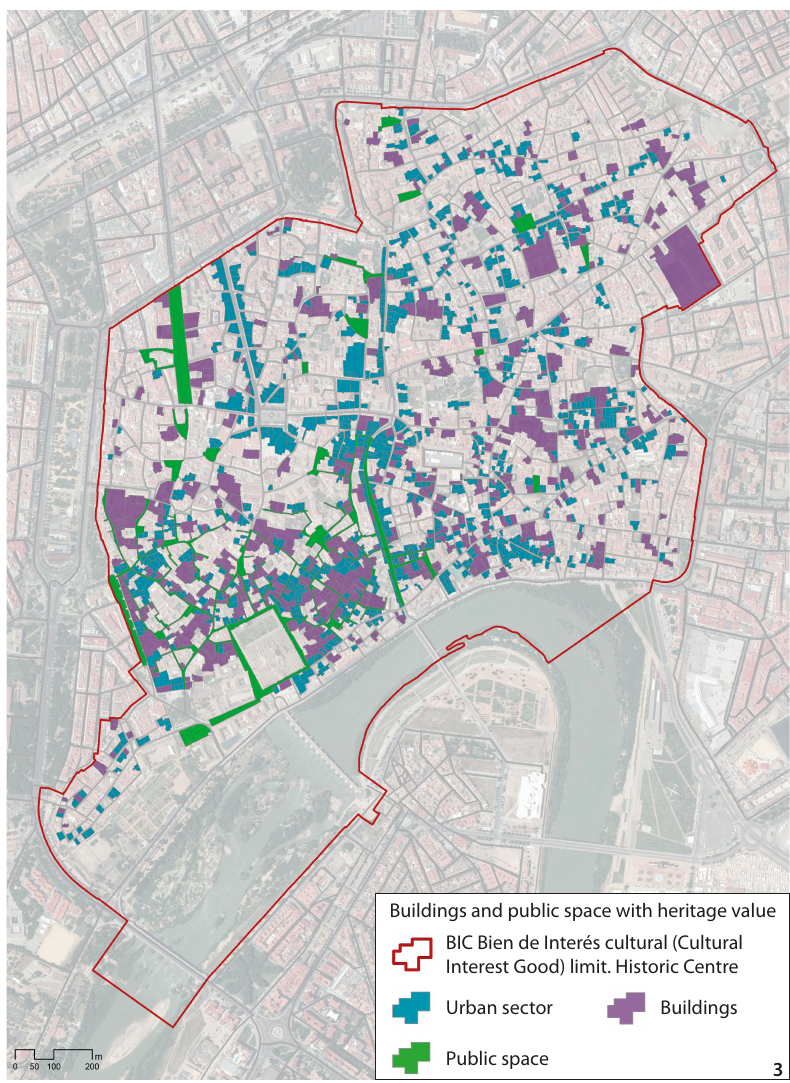
Figure 3 The Special Protection Plan of the His- torical Centre of Cordoba. A document of the Urban Plan that establish the rule of intervention in the heritage part of Córdoba (Source: PAX).